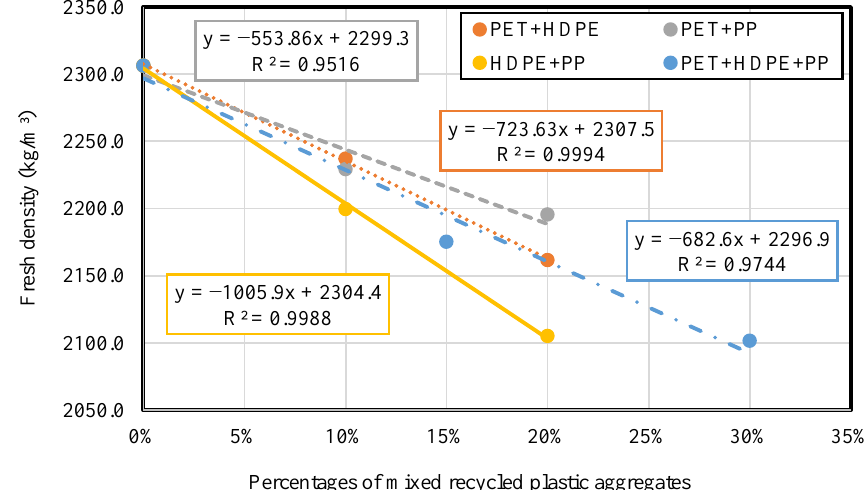
Figure 4. Variation of fresh density with mixed recycled replacement percentages.